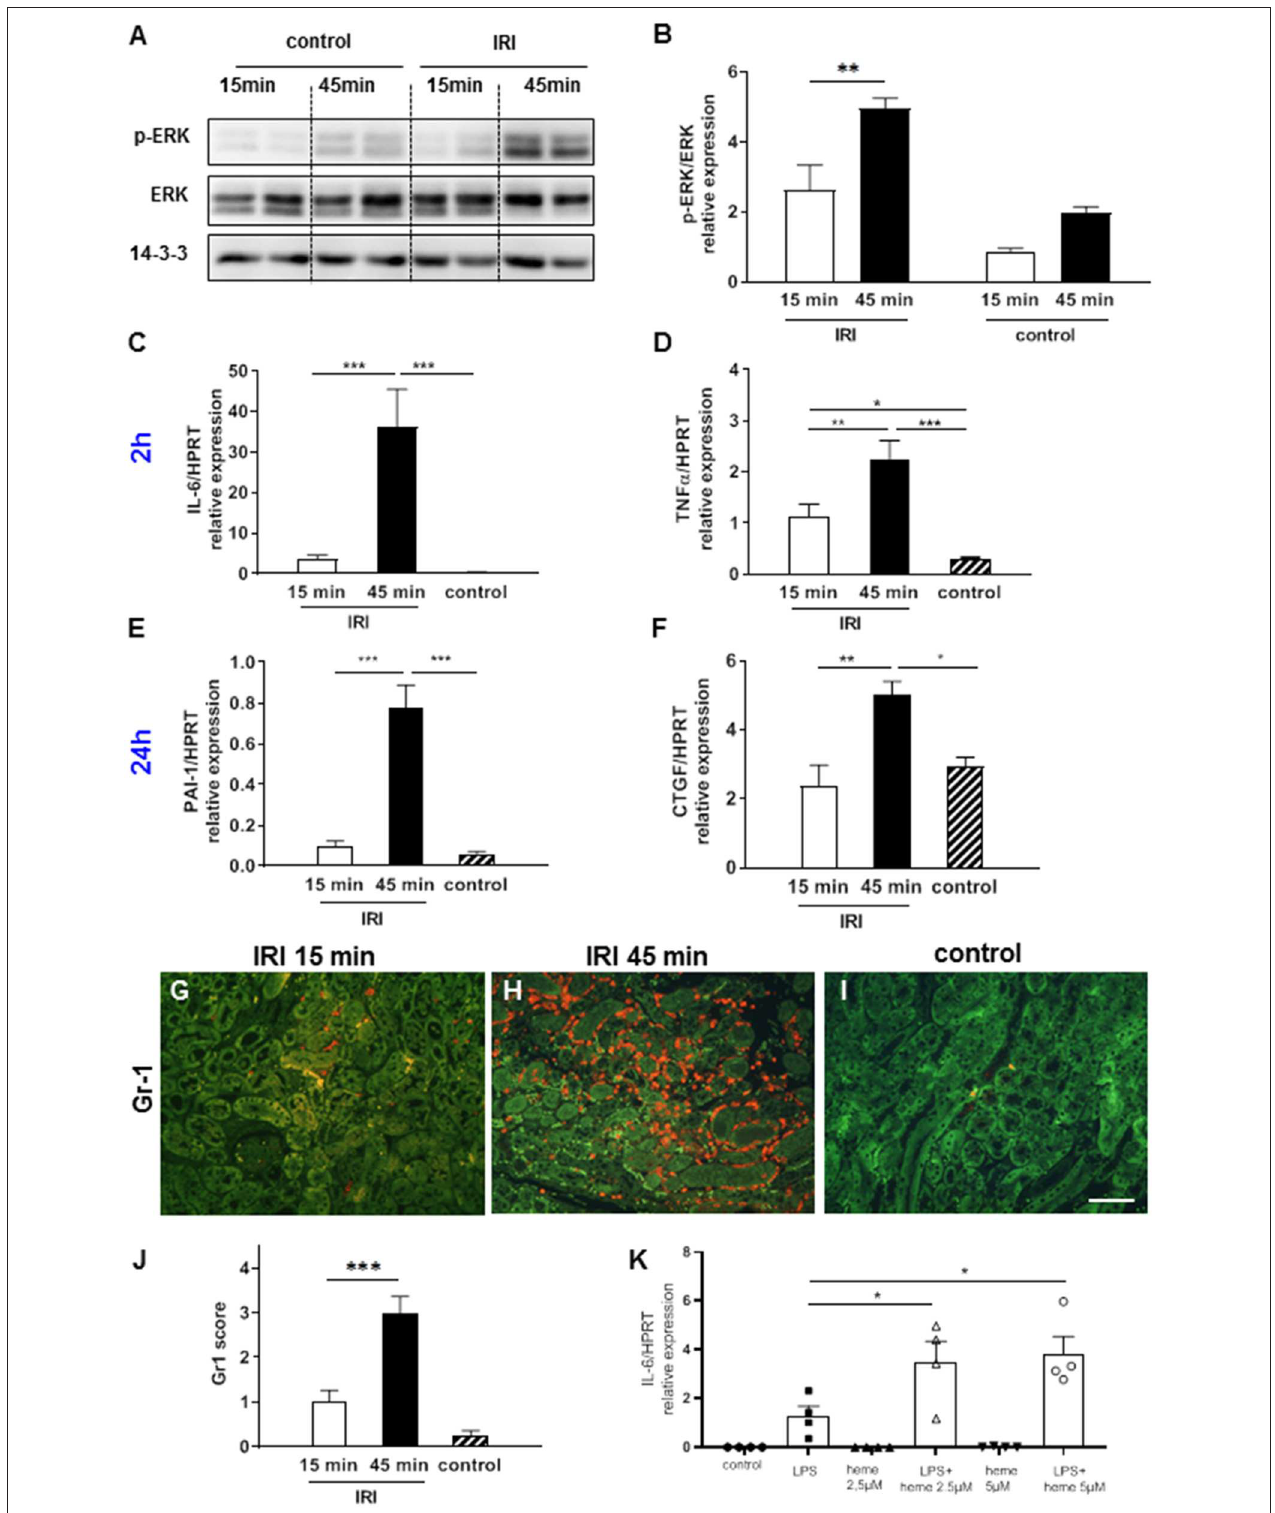
FIGURE 2 | ERK activation, cytokine expression and neutrophil infiltration after IRI. Already at 2h after IRI ERK activation was significantly enhanced in the kidneys after 45min compared to 15min IRI ( A,B , * p < 0.05). Pro-inflammatory cytokines IL-6, TNF- α at 2h (C,D) after IRI and pro-fibrotic cytokines PAI-1 and CTGF at